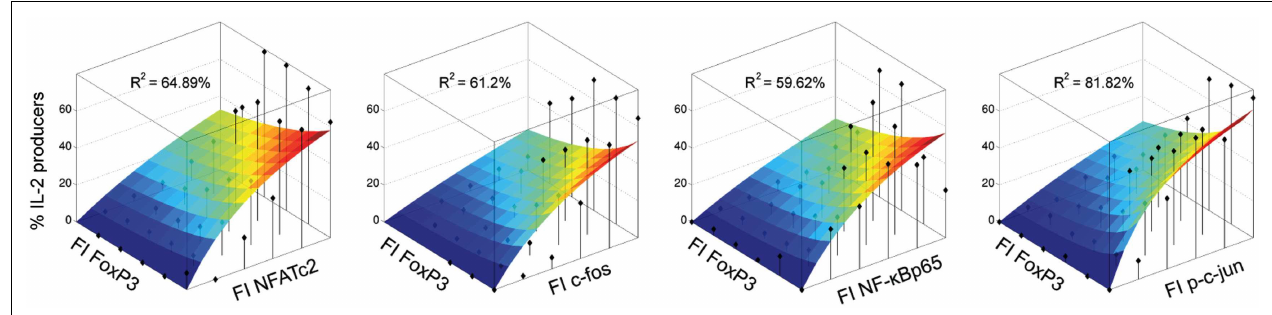
factors were divided into 2D-bins.The fraction of IL-2-expressing cells was calculated for each bin, which contained at least five cells (black diamonds). A heuristic model including an activating and an inhibiting term was fitted to the data.The landscape of the model for each data set (eachTF from one donor) is superimposed on the data and the R 2 value is